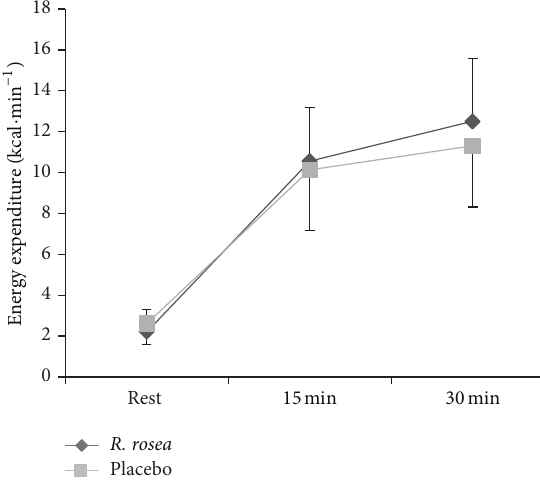
Figure 3: Mean ± S.D. energy expenditure (Kcal ⋅ min −1 ) during 30 min submaximal cycling between R. rosea and placebo condi- tions.